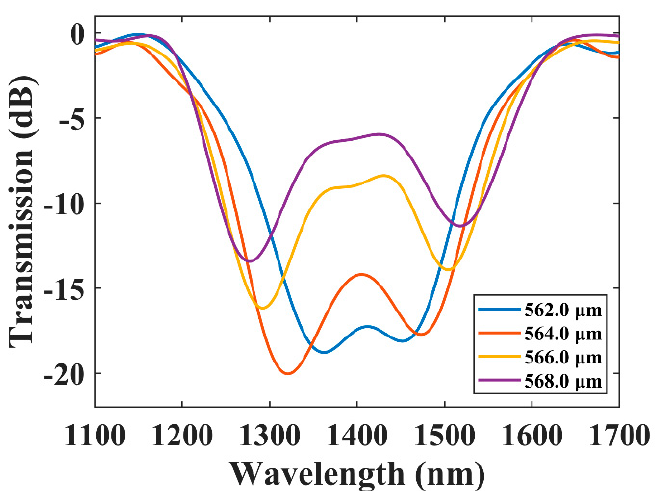
Figure 5. The transmission spectra of BLPFGs. The cladding diameter is 121 μ m, and the periods